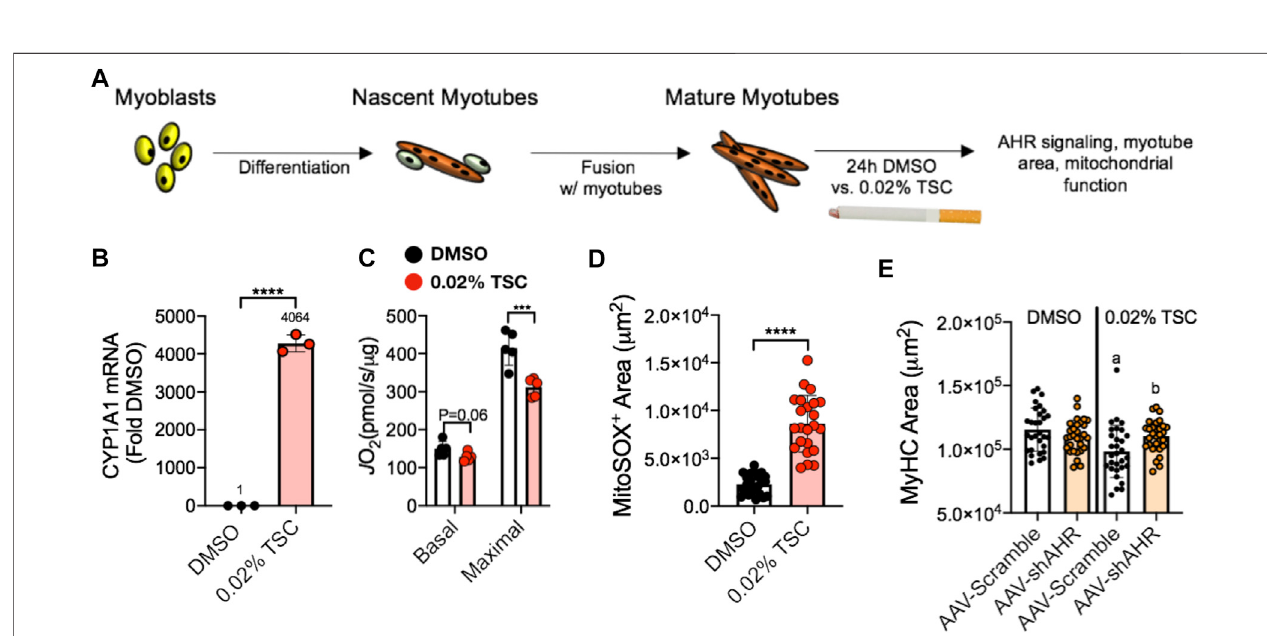
FIGURE 7 | (A) Tobacco smoke condensate (TSC) exposure in C2C12 myotubes (B) activates AHR signaling (Cyp1A1), (C) reduces mitochondrial respiratory capacity (JO2), (D) increases mitochondrial ROS (detected using a MitoSox probe), and (E) leads to reduced myotube size that is blocked by shRNA targeting the AHR (shAHR) delivered by adeno-associated virus (AAV). Figure panels adapted from (Thome et al., 2022).